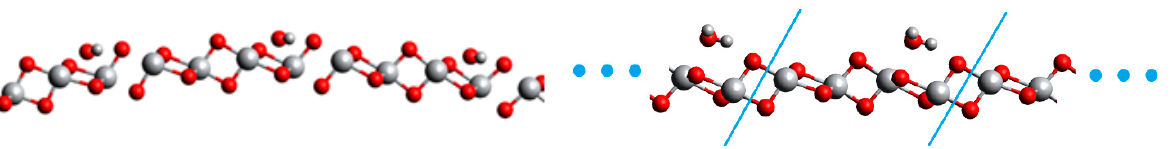
Figure 5. Fragment of a 6-layered (101) TiO 2 NT (0,40) and its 2D FVS model, with a multiplied unit cell.